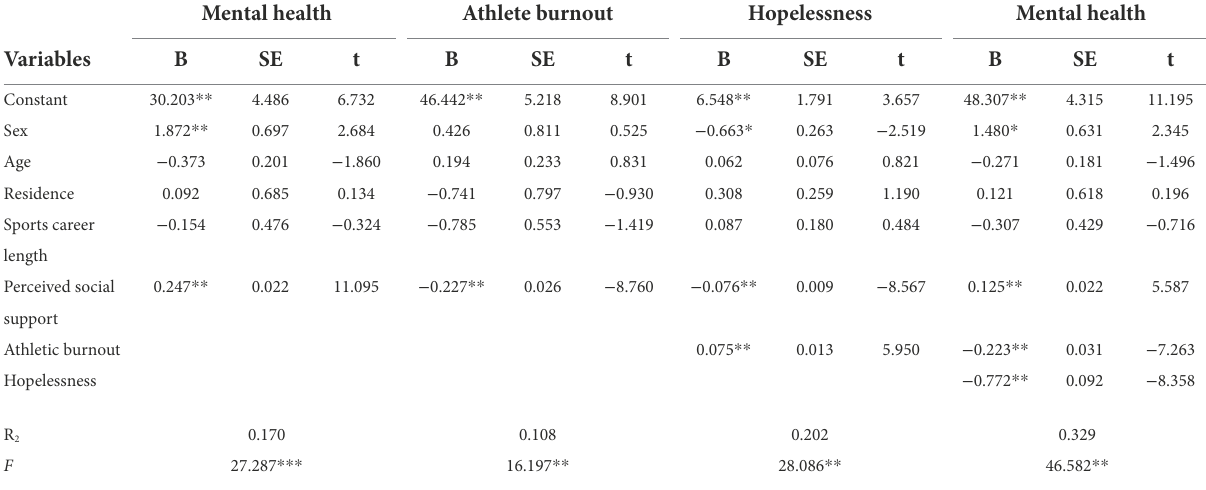
TABLE 2 Regression analysis of the relationship between variables ( n =